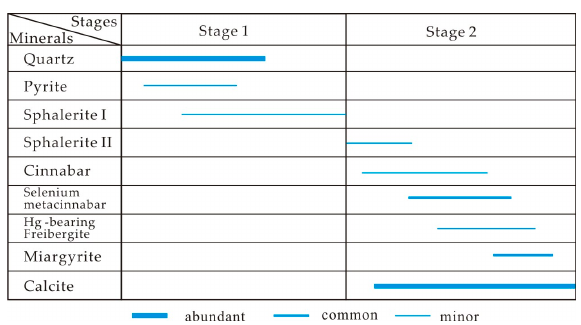
Figure 7. Paragenetic diagram of the Dongping Hg – Ag – Se deposit.